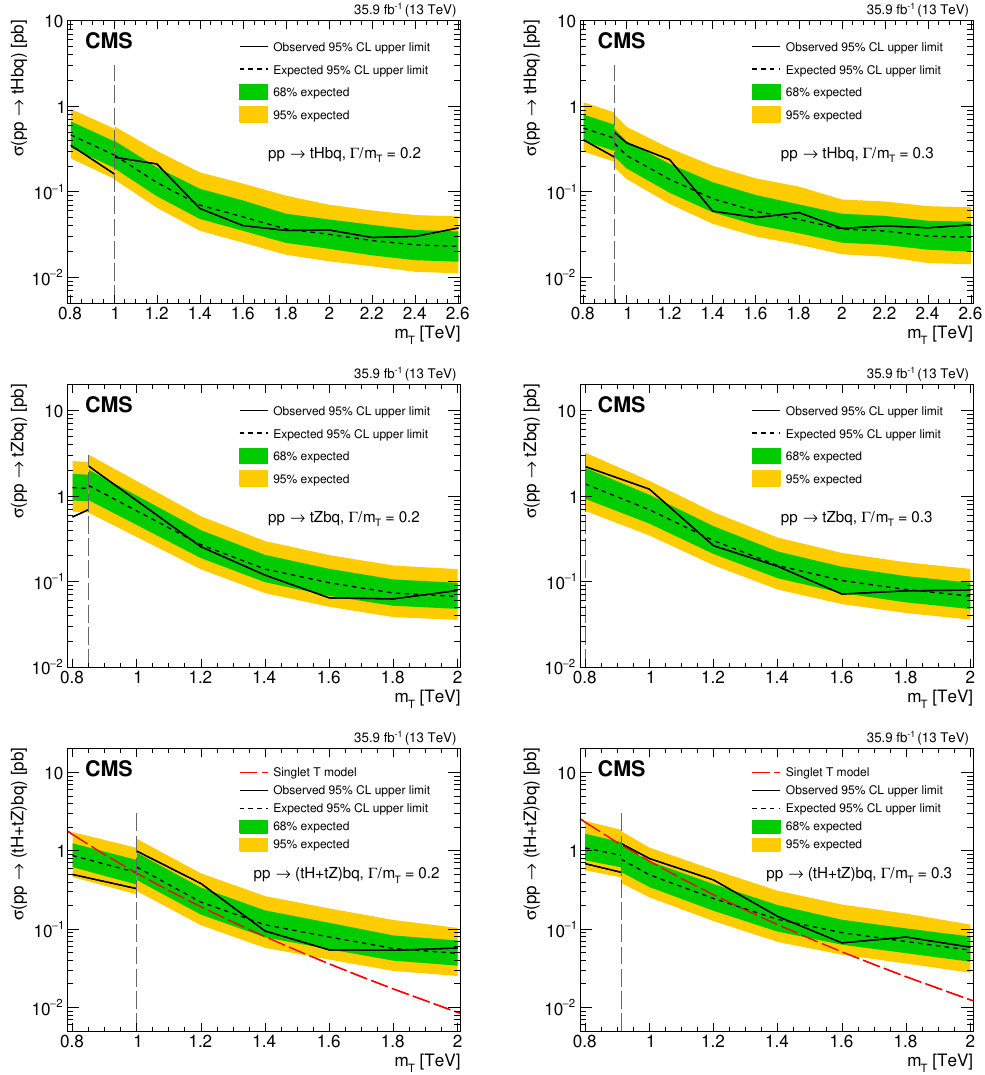
Figure 9 . The observed and median expected upper limits at 95% CL on the cross sections for production associated with a bottom quark for the tHbq (upper row) and tZbq (middle row) channels, and their sum, tHbq + tZbq (lower row), for di(cid:11)erent assumed values of the T quark mass. The inner (green) band and the outer (yellow) band indicate the regions containing 68 and 95%, respectively, of the distribution of limits expected under the background-only hypothesis. The left column is for a fractional width of 20% and the right column is for a fractional width of 30%. The vertical dashed lines are the crossover points in sensitivity that indicate the mass intervals used for presenting the low-mass and high-mass search results. The dashed red curves are for the T singlet model. Given the speci(cid:12)ed width, the couplings are implicit in the model.